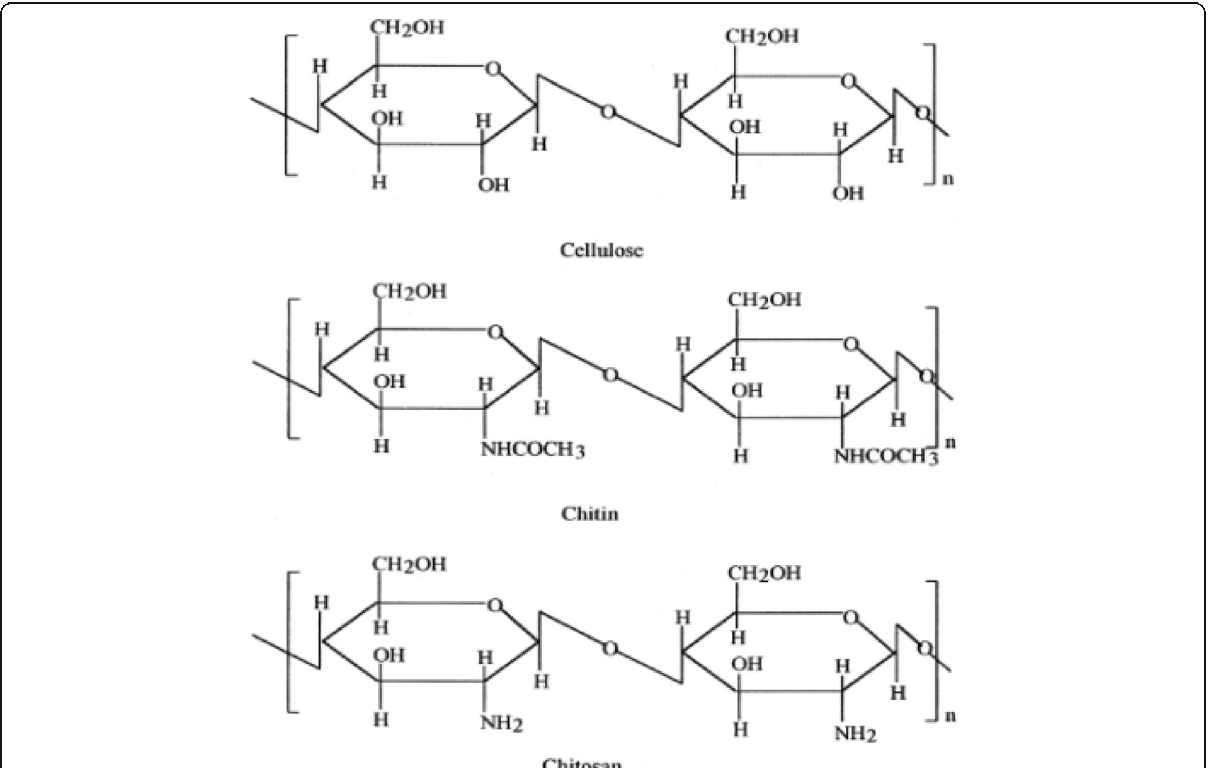
Fig. 1 Structure of cellulose, chitin, and